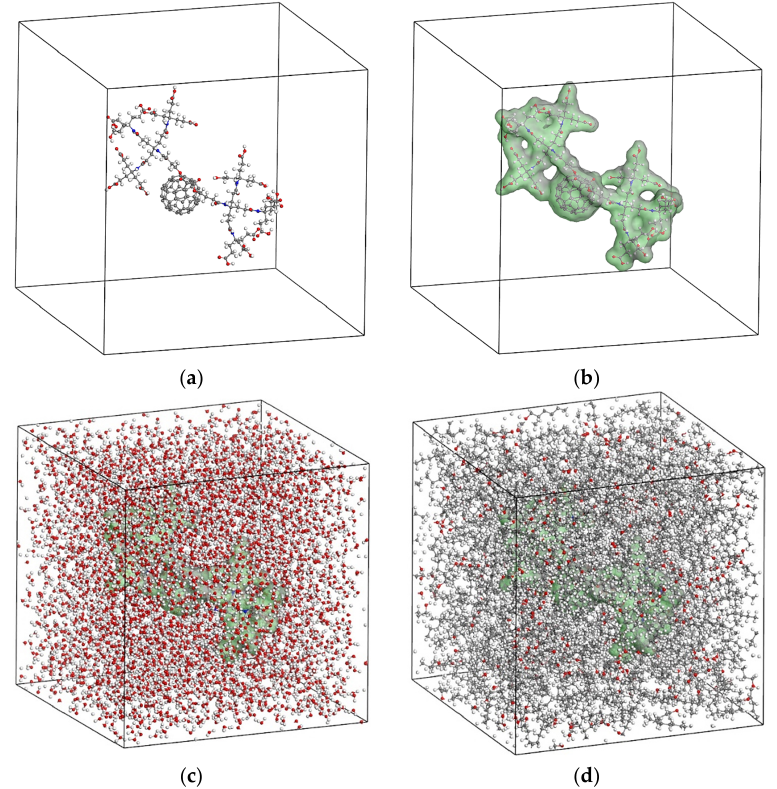
Figure 7. The unit cell for simulating the dendro[60]fullerene as a solute: ( a ) Solute central position, ( b ) solute Connolly surface, ( c ) solute in water solvent, and ( d ) solute in n-octanol solvent.